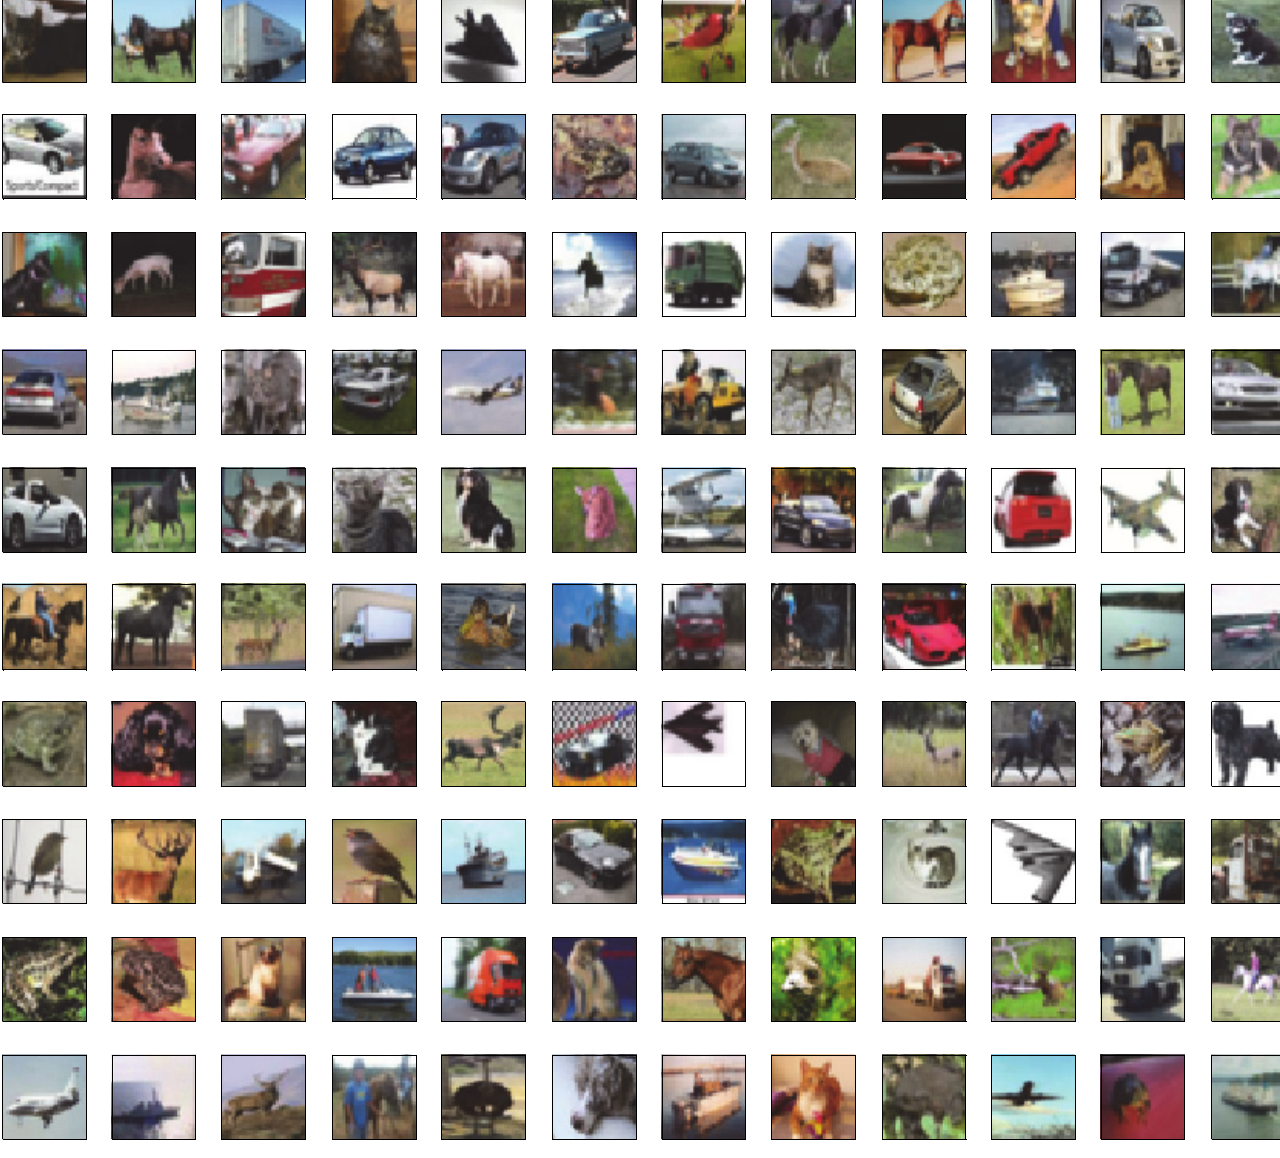
Fig. 1. Heterogeneousness and diversity of the CIFAR-10 entries in their 10 image categories. The background is diverse being either natural or artificial. The images are so tiny that, for the human eye, it takes rather a long period to conclude on some of them (e. g., try the fourth and fifth images in the bottom line from the left side). The CIFAR-10 entries vary from simpler images having a monotonous background (with an abrupt transition) to multicoloured